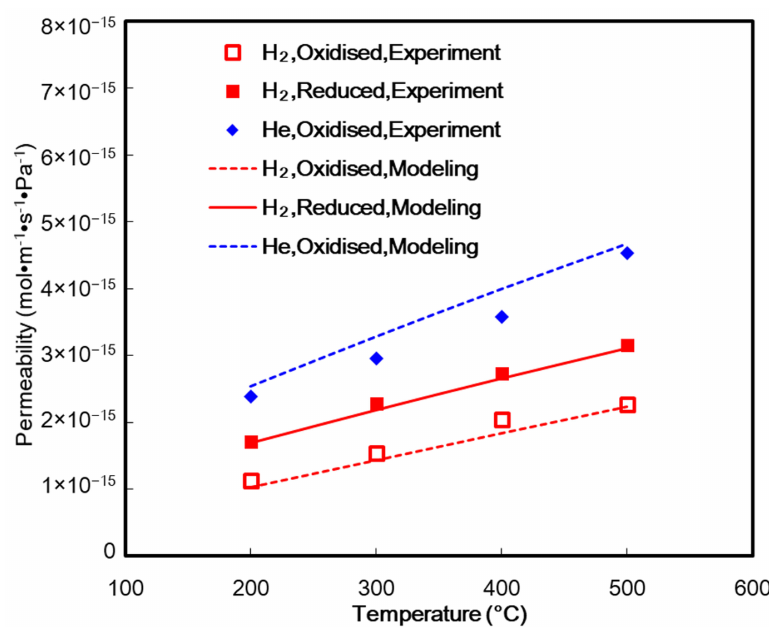
Figure 11. Comparison of permeability obtained from calculation and